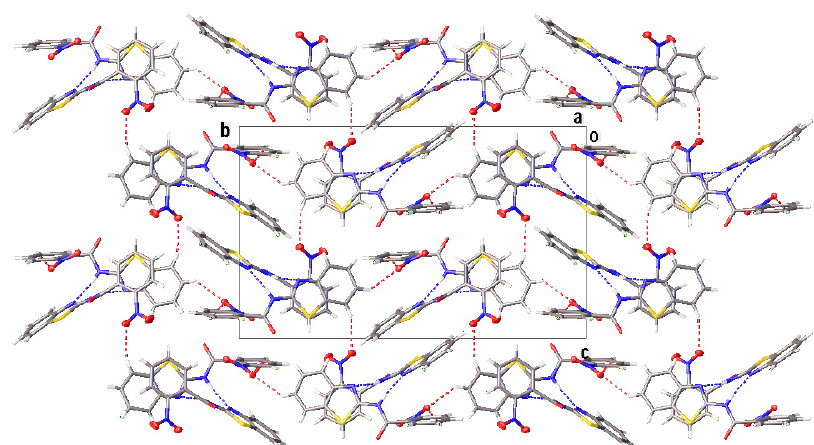
Figure 4. The partial crystal packing of I, displaying the two-dimensional framework, viewed from the a -axis. The N − H···N and C − H···O intermolecular hydrogen bonds are shown as blue and red dotted lines, respectively .